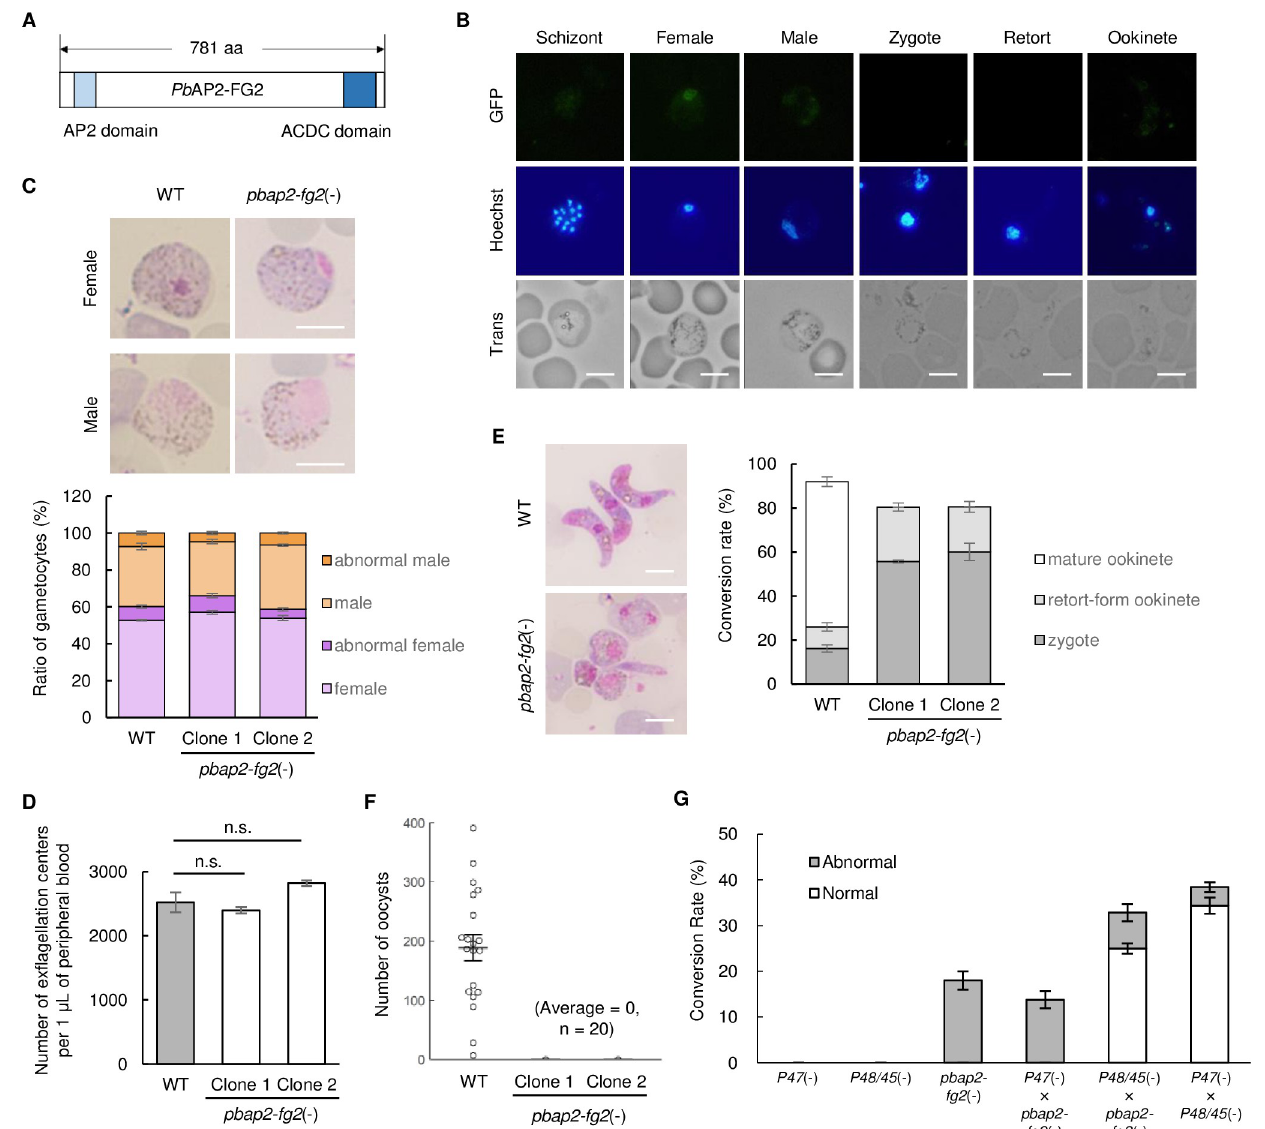
Fig 1. Expression pattern and knockout phenotype of pbap2-fg2 . (A) Schematic diagram of protein features in Pb AP2-FG2. (B) Fluorescence analysis of Pb AP2-FG2::GFP during blood-stage and sexual development. Nuclei were stained with Hoechst 33342. Scale bar = 5 μ m. (C) Top: representative Giemsa- stained images showing gametocytes of WT and pbap2-fg2 (-) parasites. Scale bar = 5 μ m. Bottom: ratio of normal/abnormal female and male gametocytes in WT and pbap2-fg2 (-). Error bars indicate the standard error of the mean (n = 3). (D) Number of exflagellation centers per 1 μ L of peripheral blood from mice infected with WT and pbap2-fg2 (-). The infected mice were treated with sulfadiazine in their drinking water to enrich gametocyte population in their blood stream. Error bars indicate the standard error of the mean (n = 3). (E) Left: representative Giemsa-stained images showing ookinetes of WT and pbap2-fg2 (-) at 20 h after starting ookinete cultures. Scale bar = 5 μ m. Right: Rate of conversion to zygote, retort-form ookinete, and mature ookinete against all female-derived cells in WT and pbap2-fg2 (-) at 20 hoc. Zygote and retort-form ookinete include morphologically abnormal cells without and with an apical protrusion, respectively. Error bars indicate the standard error of the mean (n = 3). (F) Number of midgut oocysts at 14 days post infection for WT and pbap2-fg2 (-). Lines indicate the mean values and the standard error (n = 20). (G) Cross-fertilization assay among pbap2-fg2 (-), p48/45 (-) and p47 (-). The number of normal and abnormal ookinetes are indicated as white and grey bars, respectively. Error bars indicate the standard error of the mean (n = 3). https://doi.org/10.1371/journal.ppat.1010890.g001 ookinetes (Fig 1G). Development of their fertilized females was arrested at the round zygote or retort-form ookinete, recapitulating the scenario of pbap2-fg2 (-) parasites cultured alone. In contrast, when pbap2-fg2 (-) was crossed with a line that produces infertile males [ p48/45 (-)]